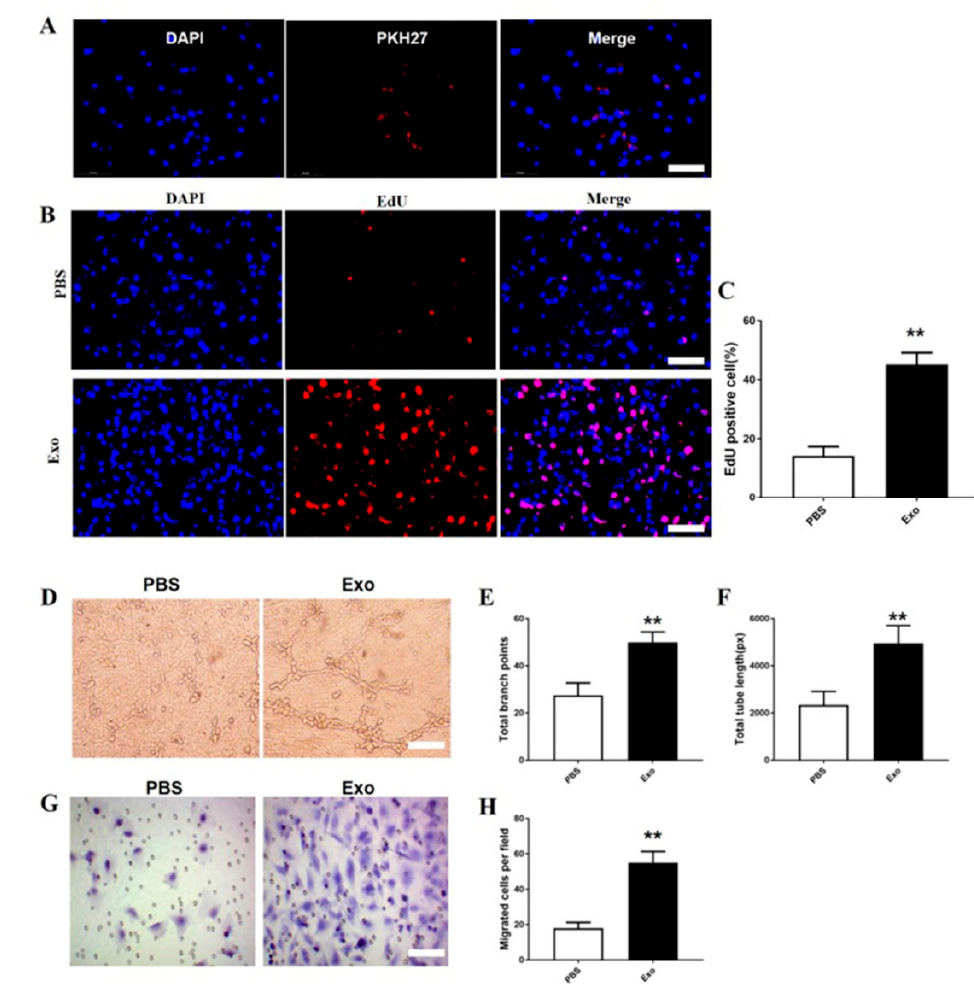
Figure 6. M2 macrophage exosomes attenuate angiogenesis, migration, and proliferation of bEnd.3 cells. PKH27-labelled exosomes uptake by bEnd.3 cells. Scale bar = 50 µ m (A). The proliferation of HUVECs in each group (B). Quantification of EdU+ cells in each group ( C ). Tube formations were measured after growing bEnd.3 cells pre-treated with exosomes or PBS. Scale bar = 500 µ m (D–F). Migration areas were measured in each group in bEnd.3 cells ( G ). Quantitative analysis of the num- bers of the migrated bEnd.3 cells ( H ). Mean ± SD. ** p < 0.01 SCI + Exo versus PBS group. N = 5 per group.